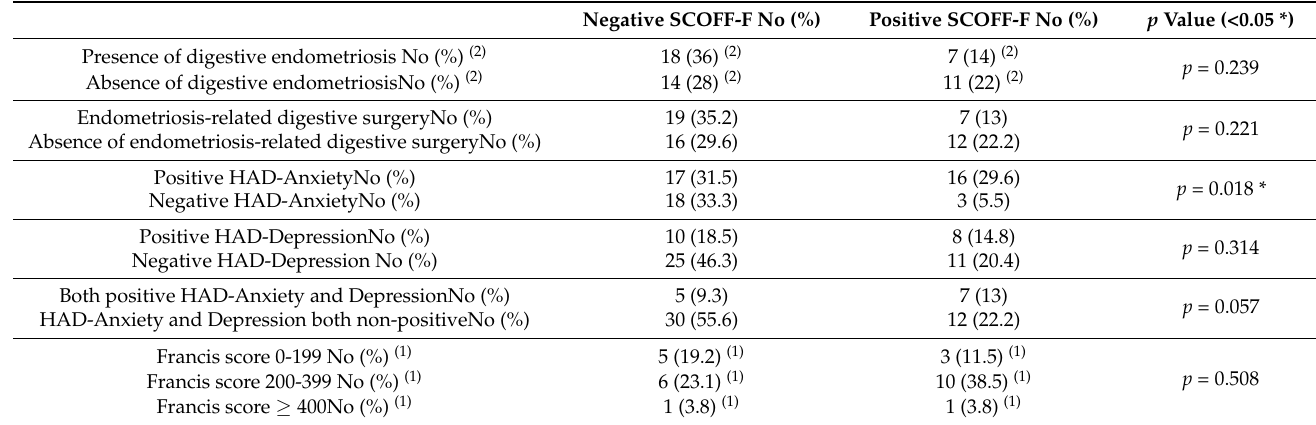
Table 4. SCOFF-F score and other variables of interest in the 54 responding patients. SCOFF-F: Sick, Control, One, Fat, Food-French version score; HAD: Hospital Anxiety and Depression Scale; *, p < 0.05.